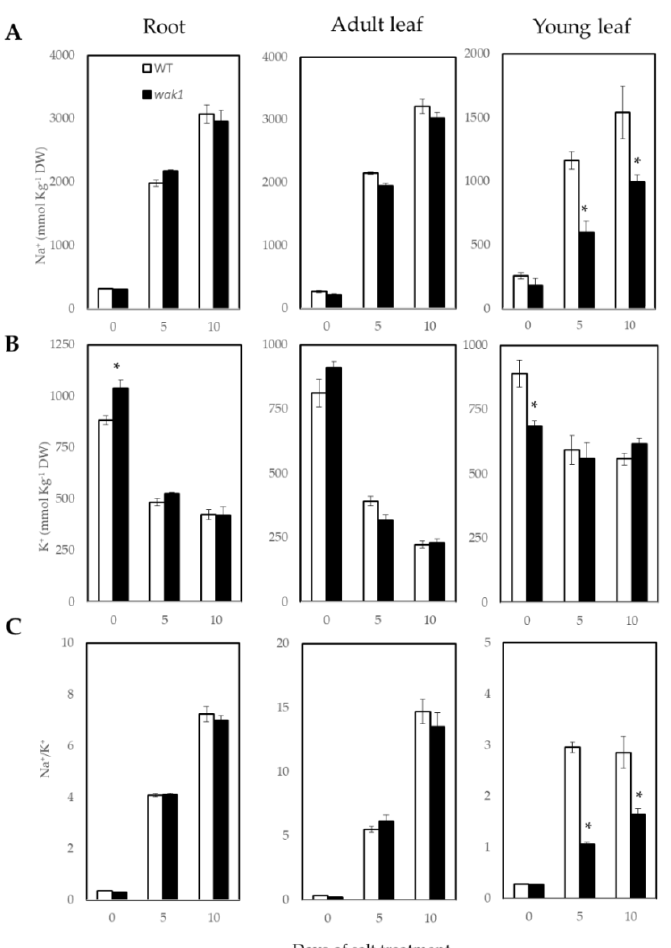
Figure 5. The Slwak1 mutant is tolerant to Na + homeostasis under salt stress. ( A ) Na + and ( B ) K + concentrations, and ( C ) Na + / K + ratio in roots, adult and young leaves of WT and Slwak1 plants after 0, 5 and 10 days of salt treatment (200 mM NaCl). Data are expressed as mean ± SE ( n = 5). Asterisks indicate significant differences between mean values of WT and Slwak1 at the same organ (Student ’ s t -test, p < 0.05).